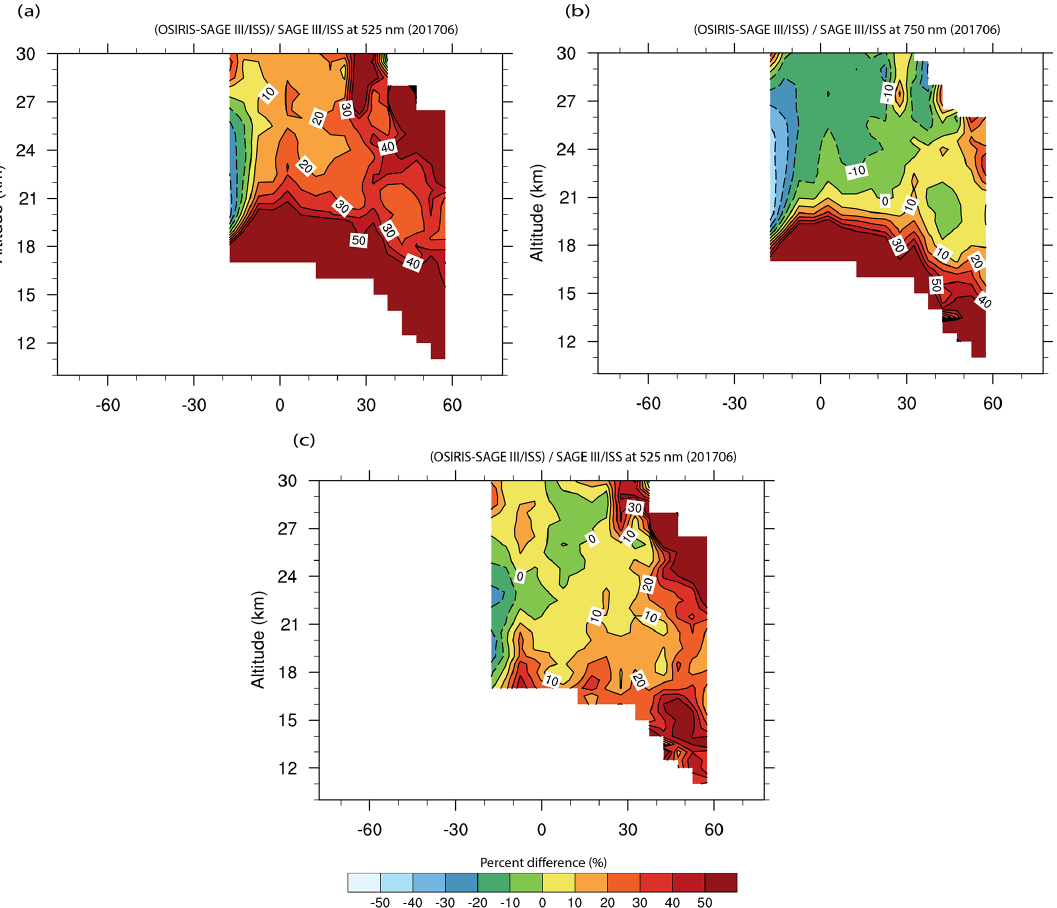
Figure 5. Altitude versus latitude of percent difference between the OSIRIS and SAGE III/ISS extinction coefficient (a) at 525nm for June 2017 and (b) at 750nm for June 2017. The OSIRIS extinction coefficient used in (a) is computed using a constant Ångström exponent of 2.33, whereas in panel (c) a monthly based pseudo Ångström exponent is used to compute OSIRIS extinction at